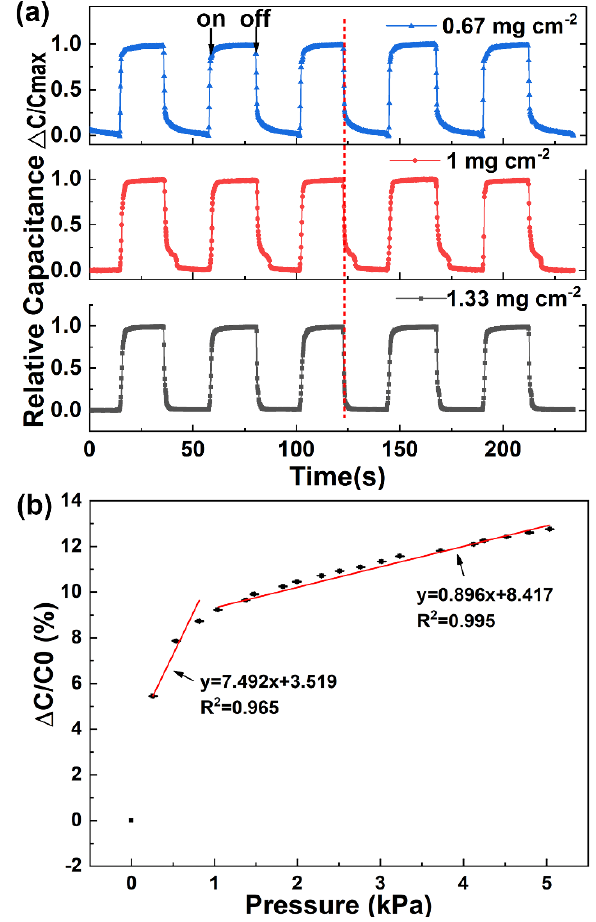
Figure 3. Optimization and characterization of the electrical properties and performances of the capacitive sensor. ( a ) Changes in capacitance under pressure on and off. ( b ) Relative change in capacitance with applied pressure. Error bars show standard deviation with N = 3.